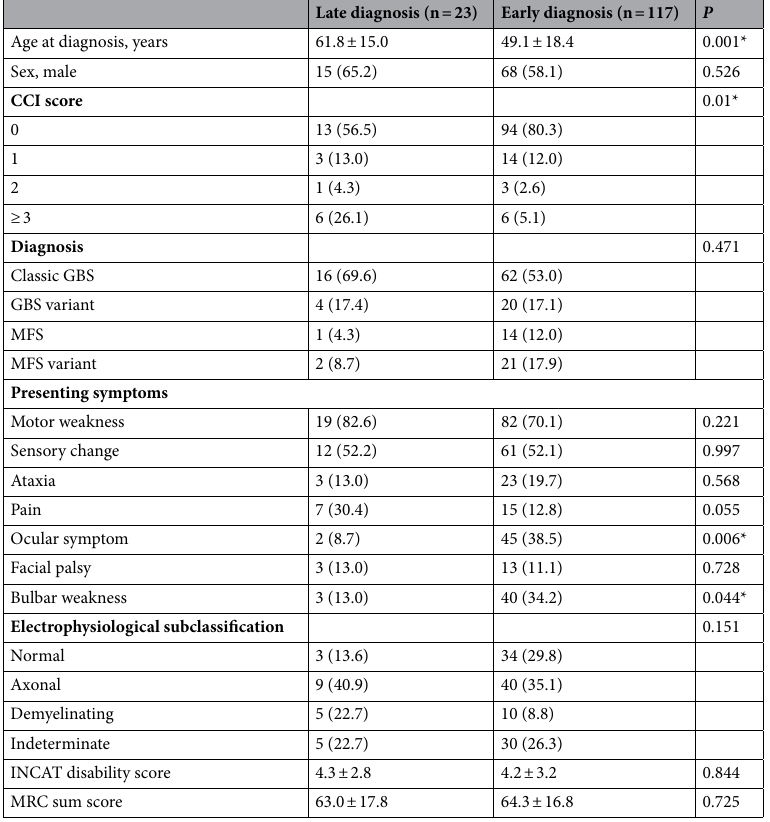
Table 1. Comparison of clinical and electrophysiological characteristics of the patients with Guillain– Barre syndrome who were diagnosed within 2 weeks and after 2 weeks from symptom onset. Early and late diagnosis are defined by time from symptom onset to confirmation of diagnosis as follows: Early(≤ 14 days) and late(≥ 15 days). CCI, Charlson Comorbidity Index; GBS, Guillain–Barré syndrome; MFS, Miller Fisher syndrome; INCAT, Inflammatory Neuropathy Cause and Treatment; MRC, Medical Research Council. * p <